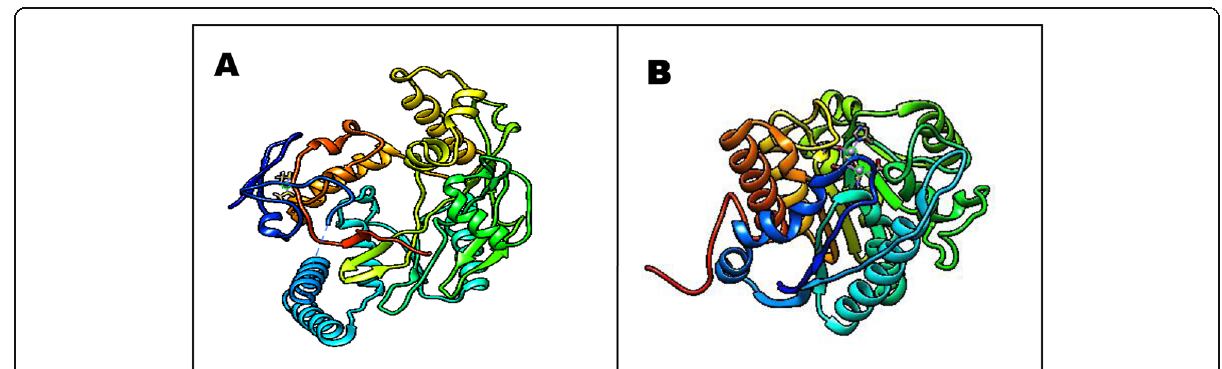
Fig. 2 Three-dimensional structures (in ribbon) of target proteins. a Nitric oxide synthase. b